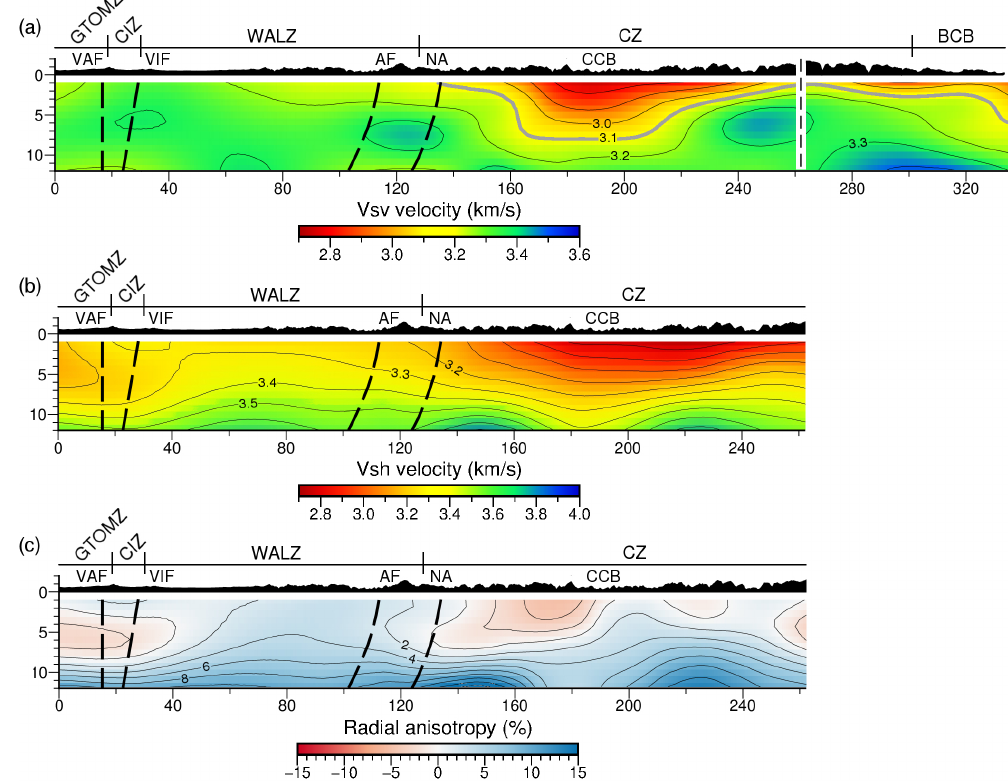
Figure 8. Cross sections through the (a) V sv , (b) V sh , and (c) radial anisotropy models (location in Fig. 1), showing the topographic relief and the trace at depth of the structures that constitute the limits of the main geological domains. The V sv cross section has been extended to the east using the model in Acevedo et al. (2019). The 3.1kms − 1 V sv velocity contour, which marks the depth of the cover–pre-Variscan basement boundary, is highlighted in grey. CCB: Central Coal Basin, NA: Narcea antiform, AF: Allande fault, VIF: Vivero fault, VAF: Valdoviño fault.